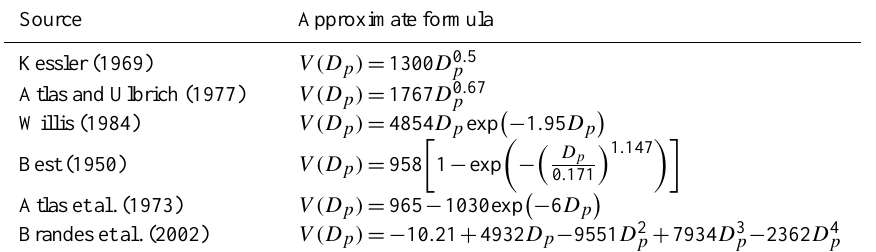
Table 1. Parameterizations for raindrop terminal velocity (in cm s − 1 ) .